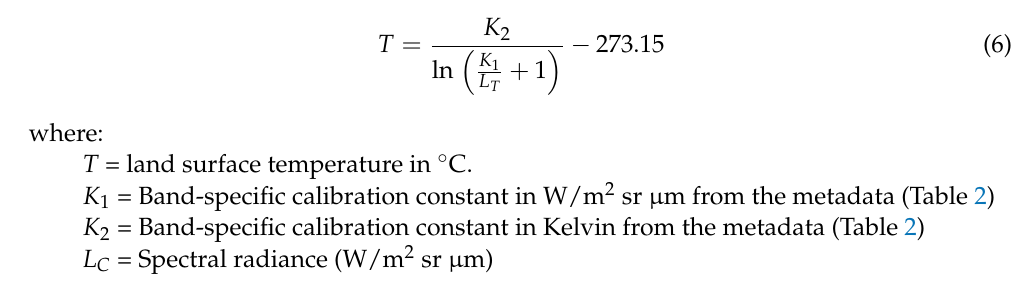
Table 2. Thermal band calibration constants for specific Landsat satellites. Band K 1 K 2 Landsat-8 OLI/TIRS Band 10